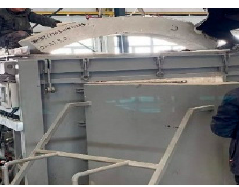
Figure 4. ( a ) Hoist the tunnel lining ( b – d ) and seal the lining structure over the high-temperature open-hearth furnace.